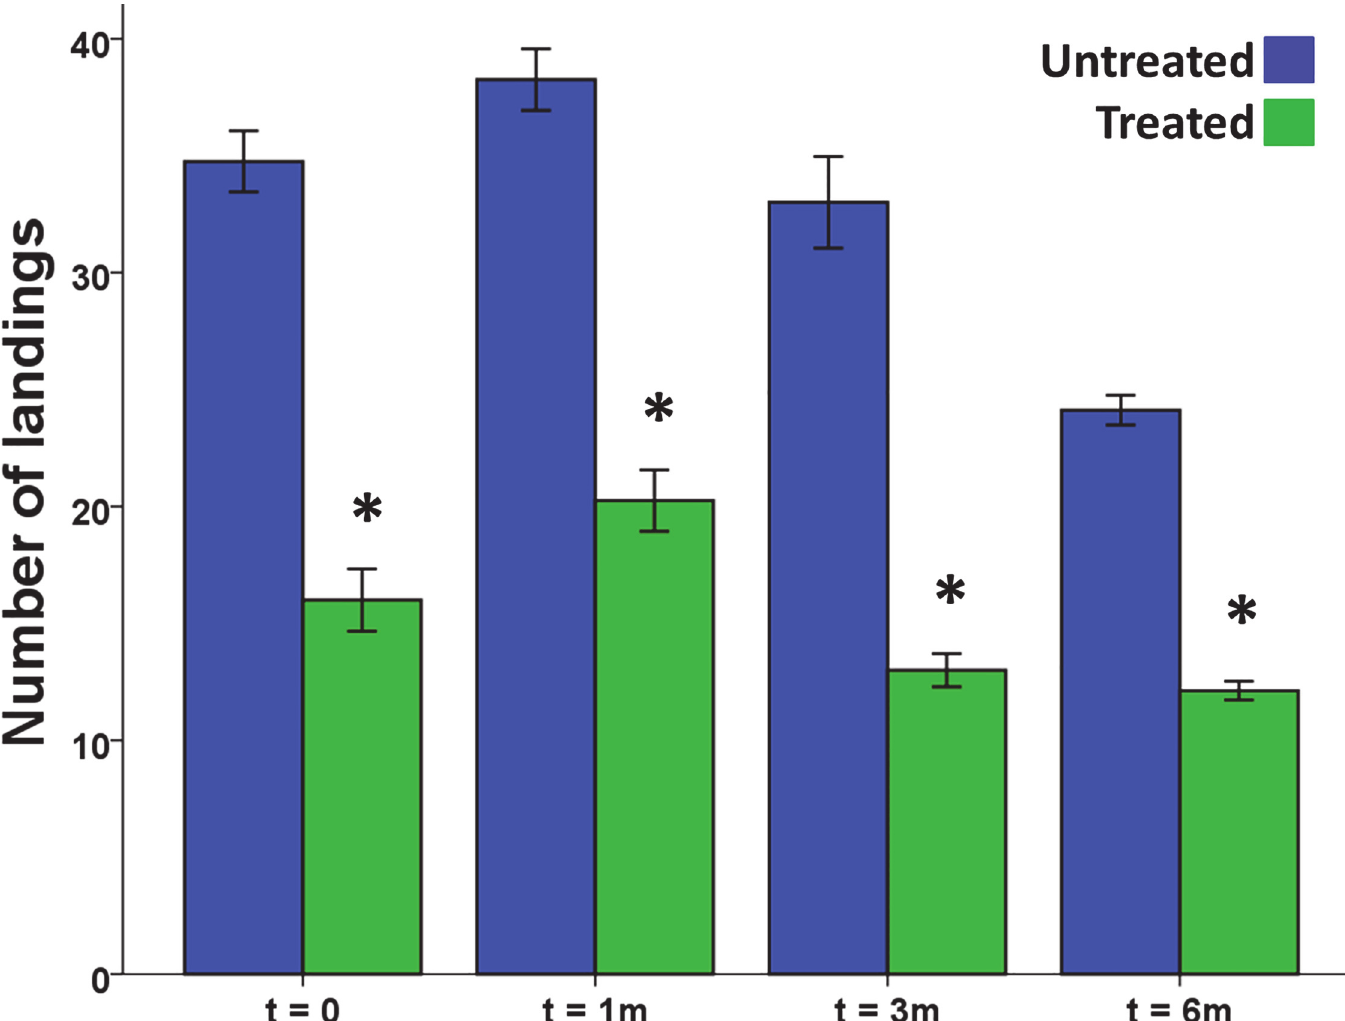
Fig 1. Mean number of mosquito landings on the control and the treated fabrics. At zero, one, three and six months after treatment. Asterisks indicate a significant difference between the control and the treatment, n = 8 for all groups, error bars indicate the standard error of the